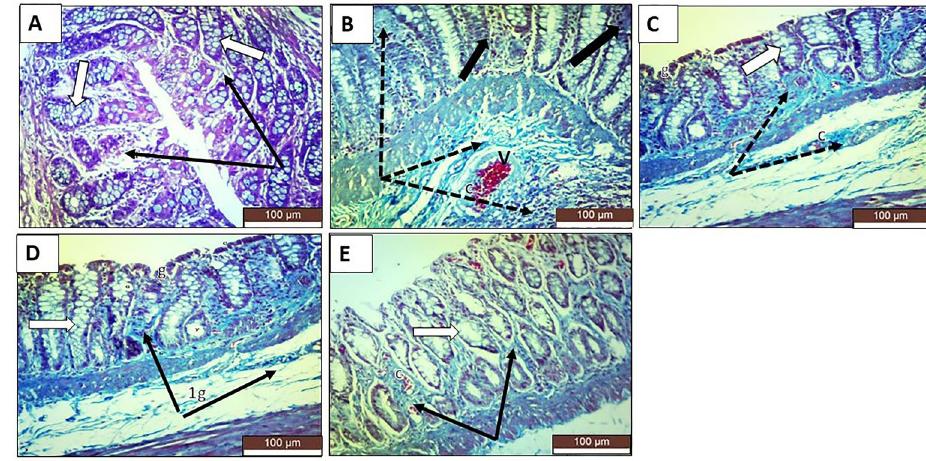
Figure 3. Photomicrographs of rat colonic sections stained with Masson trichrome ( (cid:4) 20, scale bar 100 m m). A , The normal control group shows colonic mucosa with normal crypts and goblet cells (white arrows) separated by scanty loose, blue-stained collagen (thin black arrows). B , The positive control group shows a marked increase in collagen deposition (dotted black arrows) replacing the degenerated crypts (thick black arrows) and around the congested and thickened blood vessels (c) in the submucosa. C , The sulfasalazine group shows a marked decrease in collagen (dotted black arrows) deposition between crypts (white arrow). Some crypts of Lieberkühn showed ulceration and leucocyte accumulation. Some congested blood vessels (c) in the propria submucosa and numerous goblet cells (g) are seen. D , The oral ro fl umilast group shows a moderate decrease in collagen fi bers (black arrows) between colonic crypts (white arrow) and in submucosa. Numerous goblet cells (g) and some congested blood vessels are seen between the crypts of Lieberkühn. E , The rectal ro fl umilast group shows a mild decrease in collagen deposition (black arrows) between colonic crypts (white arrow), ulcerated crypts of Lieberkühn, and congested blood vessels (c) with leucocyte accumulation.